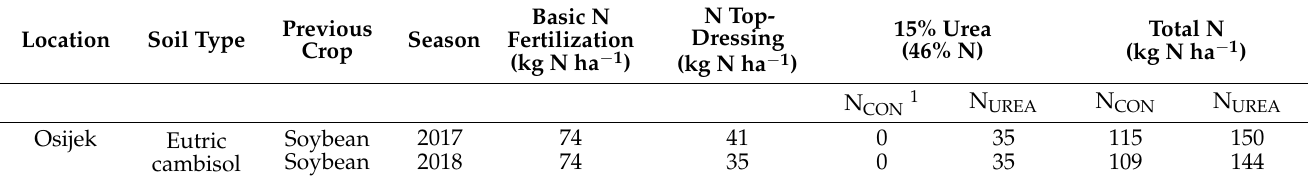
Table 2. Soil N content in Osijek in 2017 and 2018.